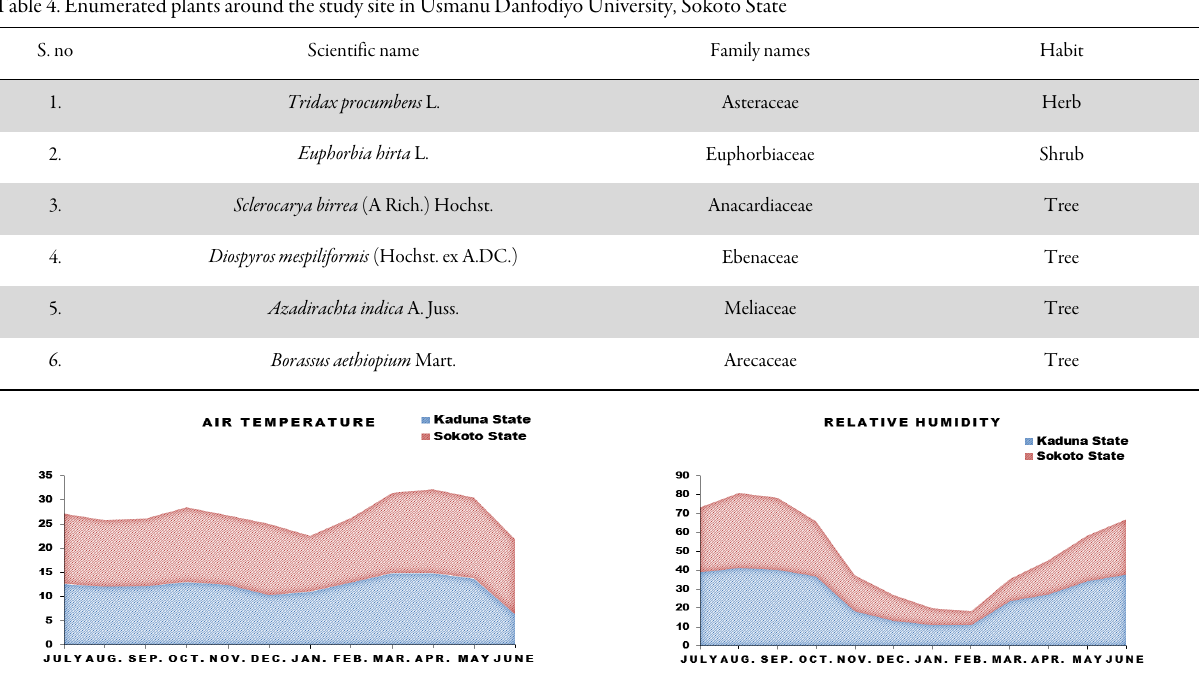
Fig. 5. Mean monthly relative humidity values (%) in Kaduna and Sokoto